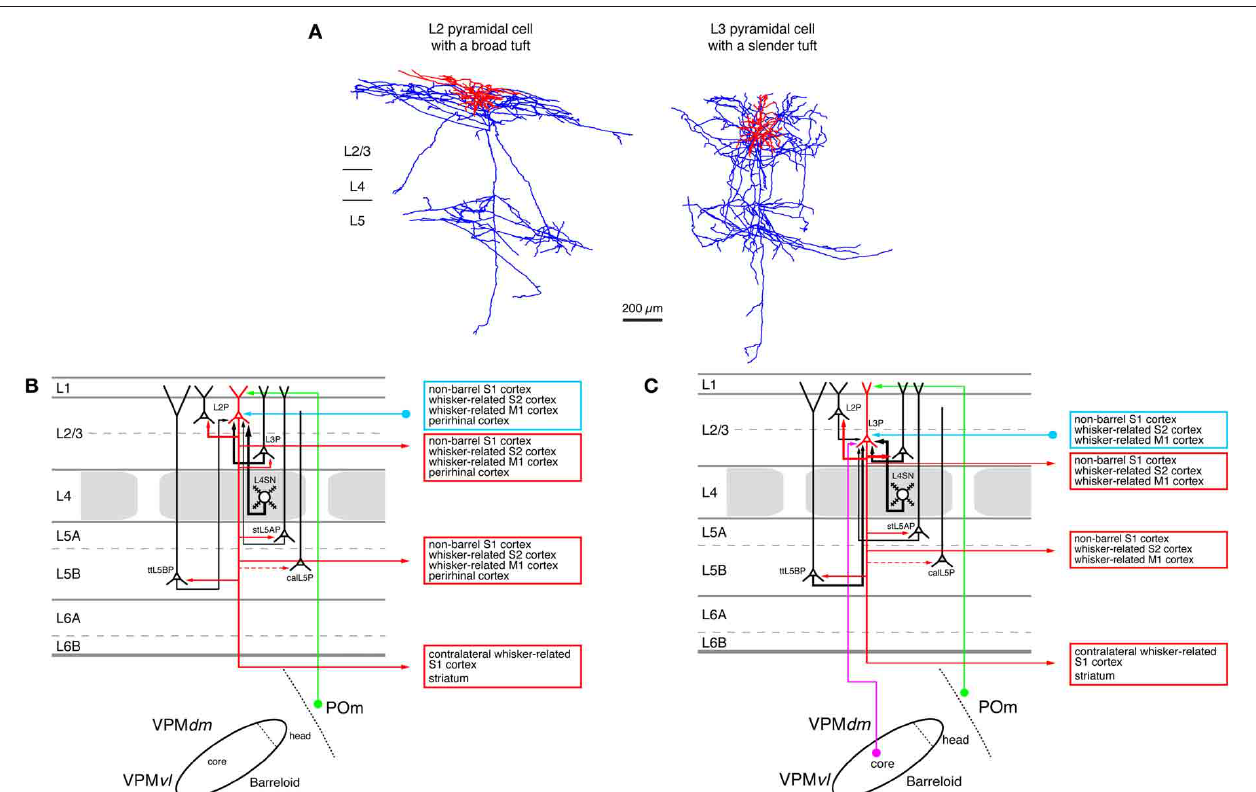
FIGURE 5 | Excitatory synaptic input–output relationship in layer 2/3 of the S1 barrel cortex. (A) Reconstructions of a pyramidal cell located in the upper half of layer 2/3 (L2 pyramidal cell, left) and a pyramidal cell located in the lower half of layer 2/3 (L3 pyramidal cell, left) of rat barrel cortex (Bruno et al., 2009); modified with permission of the Society of Neuroscience. Note that the apical tuft of the L2 pyramidal cell is substantially larger than the basal dendritic tree of that neuron while L3 pyramidal cells have slender apical tufts. Modified with permission from the Society of Neuroscience. (B) Diagram of the excitatory synaptic connections of and onto L2 pyramidal